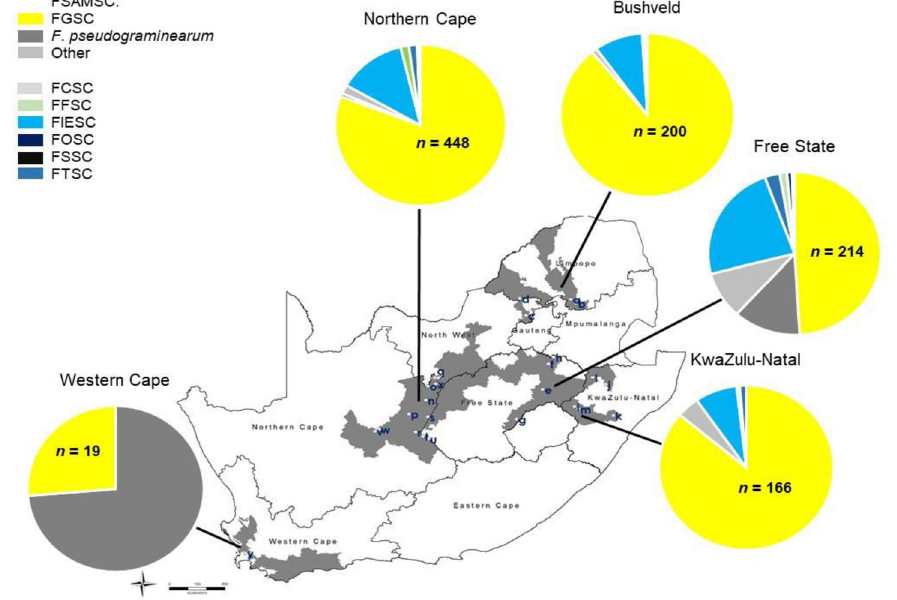
Fig 1. Geographical distribution of Fusarium species obtained from diseased wheat heads in South Africa during 2008 and 2009, according to the total number of Fusarium isolates obtained ( n ). Bushveld: a = Marble Hall, b = Groblersdal, c = Brits, d = Koedoeskop; Free State: e = Bethlehem, f = Frankfort, g = Ladybrand, h = Villiers; KwaZulu-Natal, i = Bergville, j = Dundee, k = Greytown, l = Newcastle, m = Winterton; Northern Cape: n = Barkly West, o = Bull Hill, p = Douglas, q = Hartswater, r = Hopetown, s = Modderrivier, t = Orania 1, u = Orania 2, v = Prieska, w = Remhoogte, x = Vaalharts; Western Cape: y = Vissershok. FSAMSC = F . sambucinum species complex. FGSC = Fusarium graminearum species complex, species observed include F . graminearum , F . boothii , F . meridionale , F . acaciae-mearnsii , F . brasilicum , and F . cortaderiae . Other FSAMSC = members of the FSAMSC other than FGSC and F . pseudograminearum : F . armeniacum , F . brachygibbosum , F . cerealis , F . culmorum , F . lunulosporum , F . poae , and unknown Fusarium species within the FSAMSC. FCSC = Fusarium chlamydosporum species complex: F . chlamydosporum clade 1 and clade 5 (O’Donnell et al ., 2009), and unknown Fusarium species within the FCSC. FFSC = Fusarium fujikuroi species complex: F . subglutinans , F . temperatum , F . verticillioides , and unknown Fusarium species within the FFSC. FIESC = Fusarium incarnatum - equiseti species complex. FOSC = Fusarium oxysporum species complex: Fusarium oxysporum , and unknown Fusarium species within the FOSC. FSSC = F . solani species complex: F